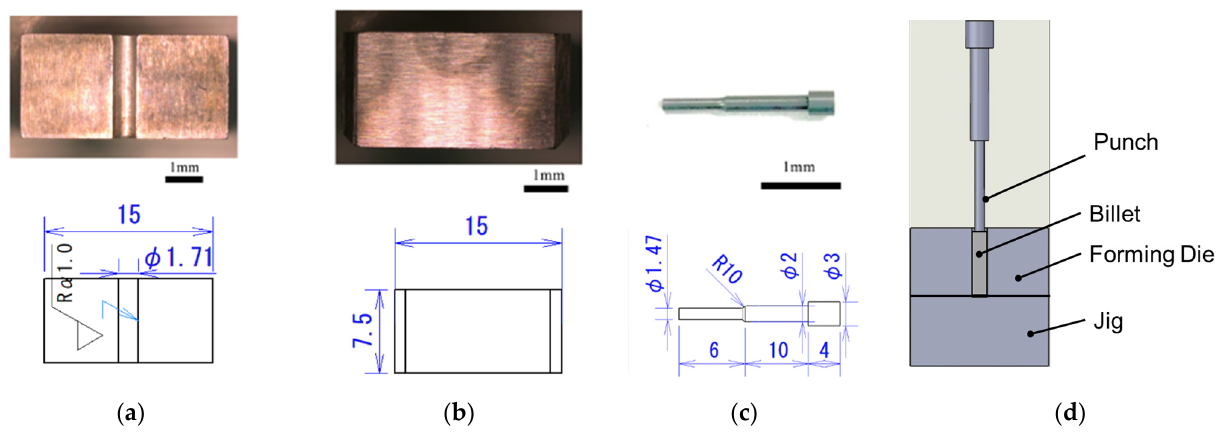
Figure 2. Dimensions of die and punch: ( a ) forming die, ( b ) jig, ( c ) punch, and ( d ) schematic view of backward microextrusion.